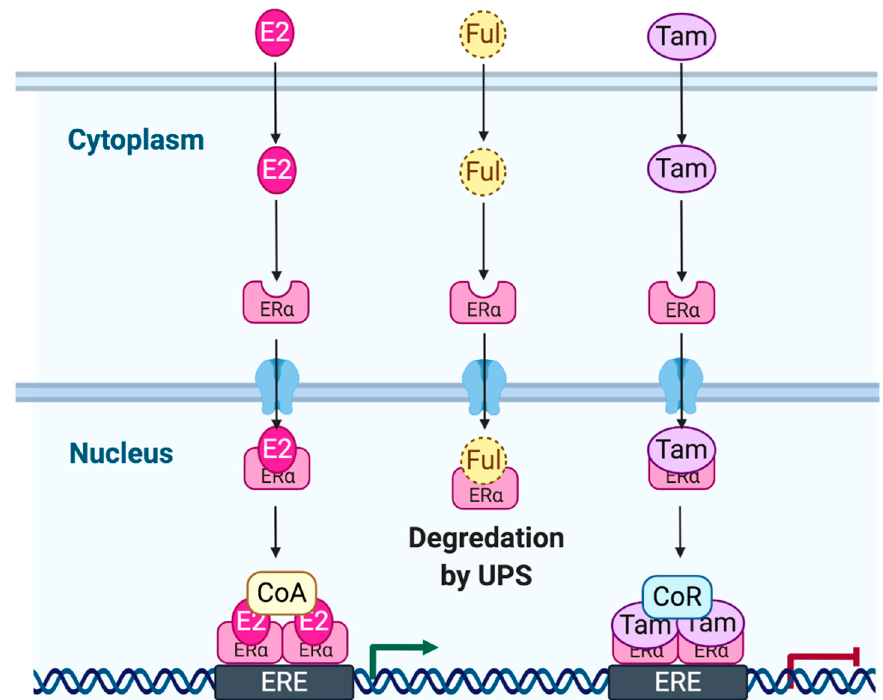
Figure 1. Simplistic representation of estrogen receptor (ER) signaling (genomic activity). Estrogen